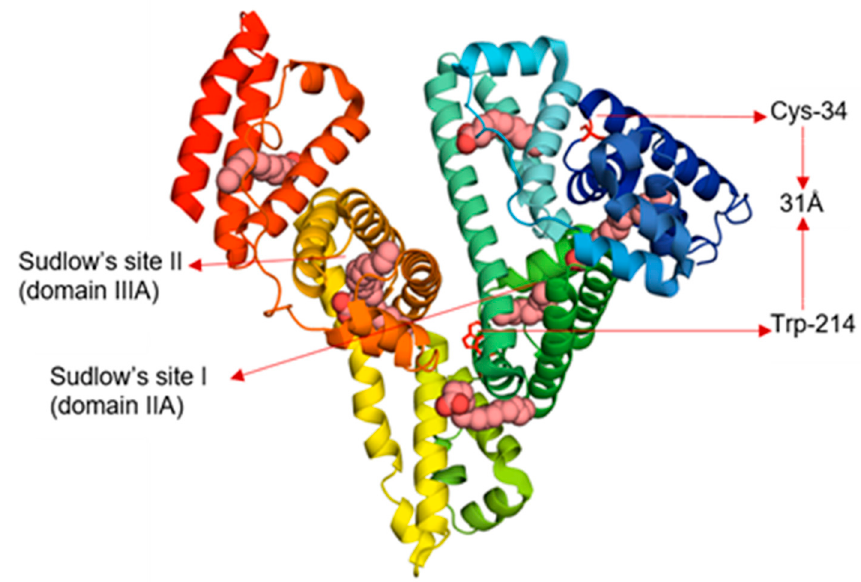
Figure 1. Human serum albumin (HSA) complexed with seven molecules of palmitic acid (PDB 1e7h). The different colors in HSA represent the six subdomains and the pink space filling models represent palmitic acid (PA). The Förster resonance energy transfer (FRET) distance between Trp-214 and Cys-34 in HSA is about 31 Å.